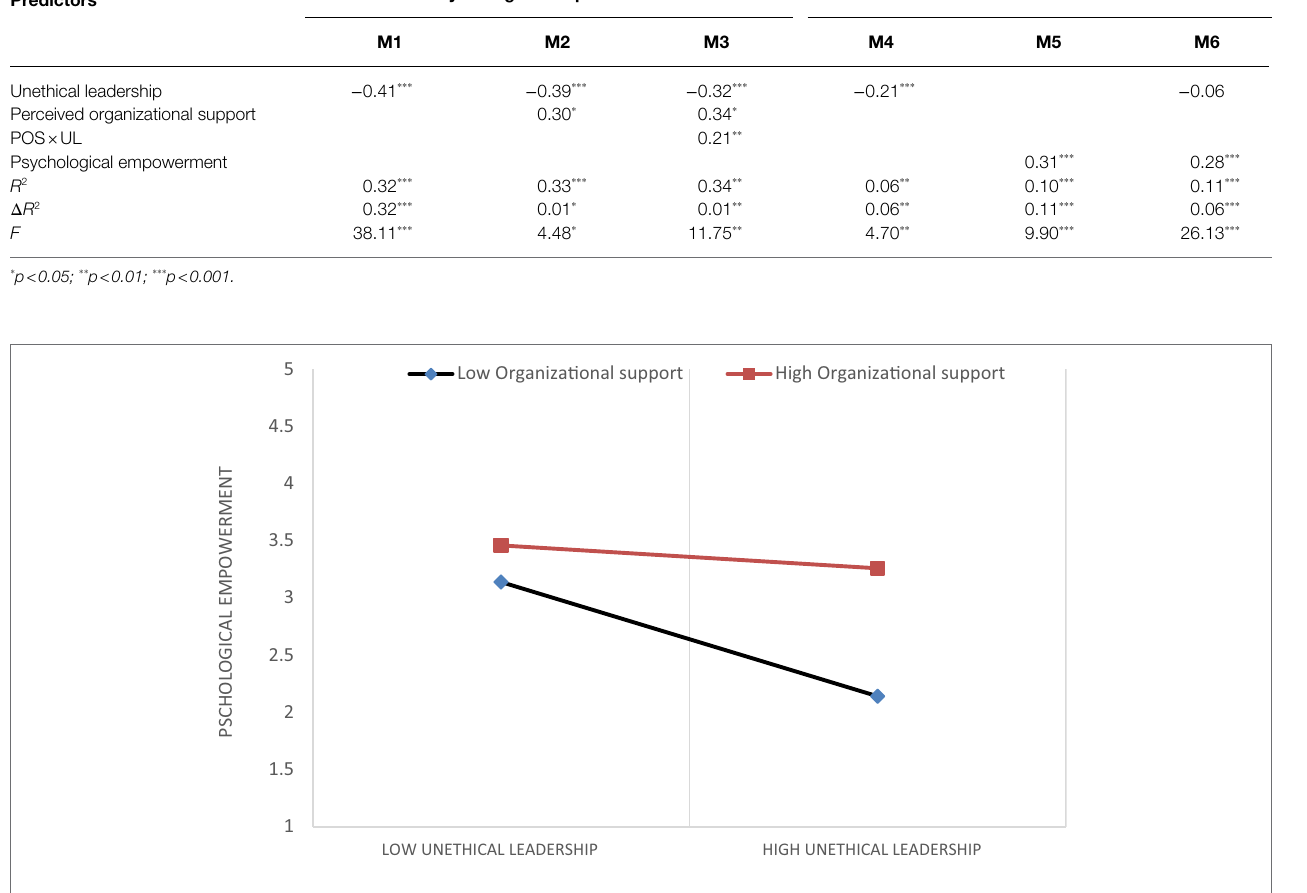
FIGURE 2 | Moderating role of perceived organizational support in the relationship between unethical leadership and psychological empowerment.